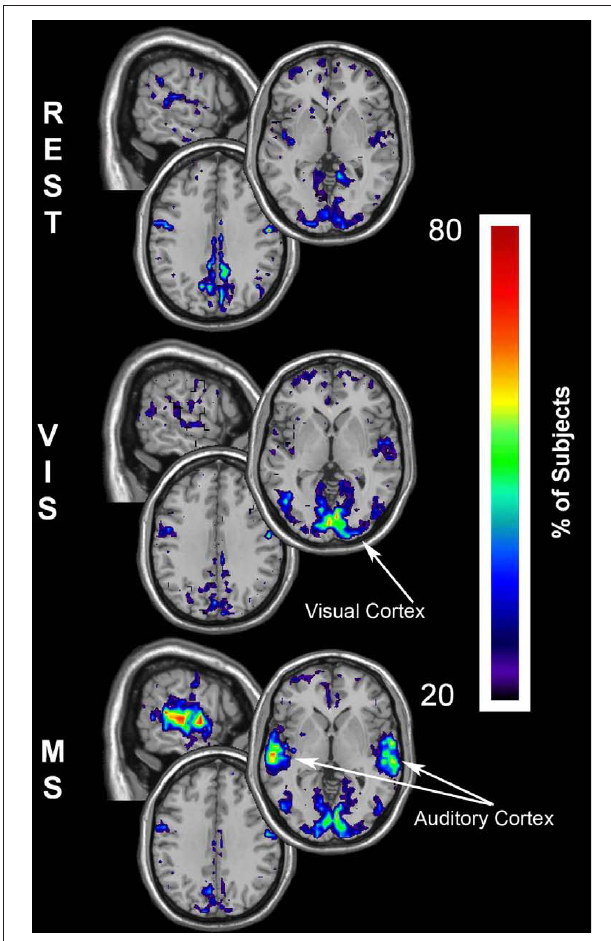
Figure 7 | global efficiency overlay maps, during rest, visual, and multisensory tasks. In each subject the voxels with global efficiency values in the top 15% were identified. These maps represent the overlap of these voxels across subjects in each of the three tasks. The consistency of overlap across subjects is indicated by the threshold color bar that represents the percentage of individuals. E maps show that at rest (REST) the visual and parietal regions glob have the greatest across-network communication. There is a primary regional shift in global efficiency during the visual task (VIS) to the visual cortex and to both the visual and auditory cortices during the multisensory task (MS). In addition to this, there is a decrease in global efficiency within the parietal cortex across the three tasks. Note however, the relative change in the spatial location of high E nodes was limited compared to K and E glob loc